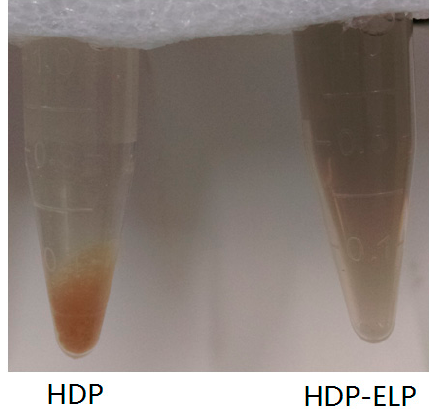
Figure 3. Solutions containing HDP and HDP ‐ ELP after 90 min. In the tube containing the enzyme HDP, enzyme aggregated and precipitated onto the bottom of the tube after 90 min of reaction; in the tube containing HDP ‐ ELP, enzyme aggregation was not obviously observed after 90 min.